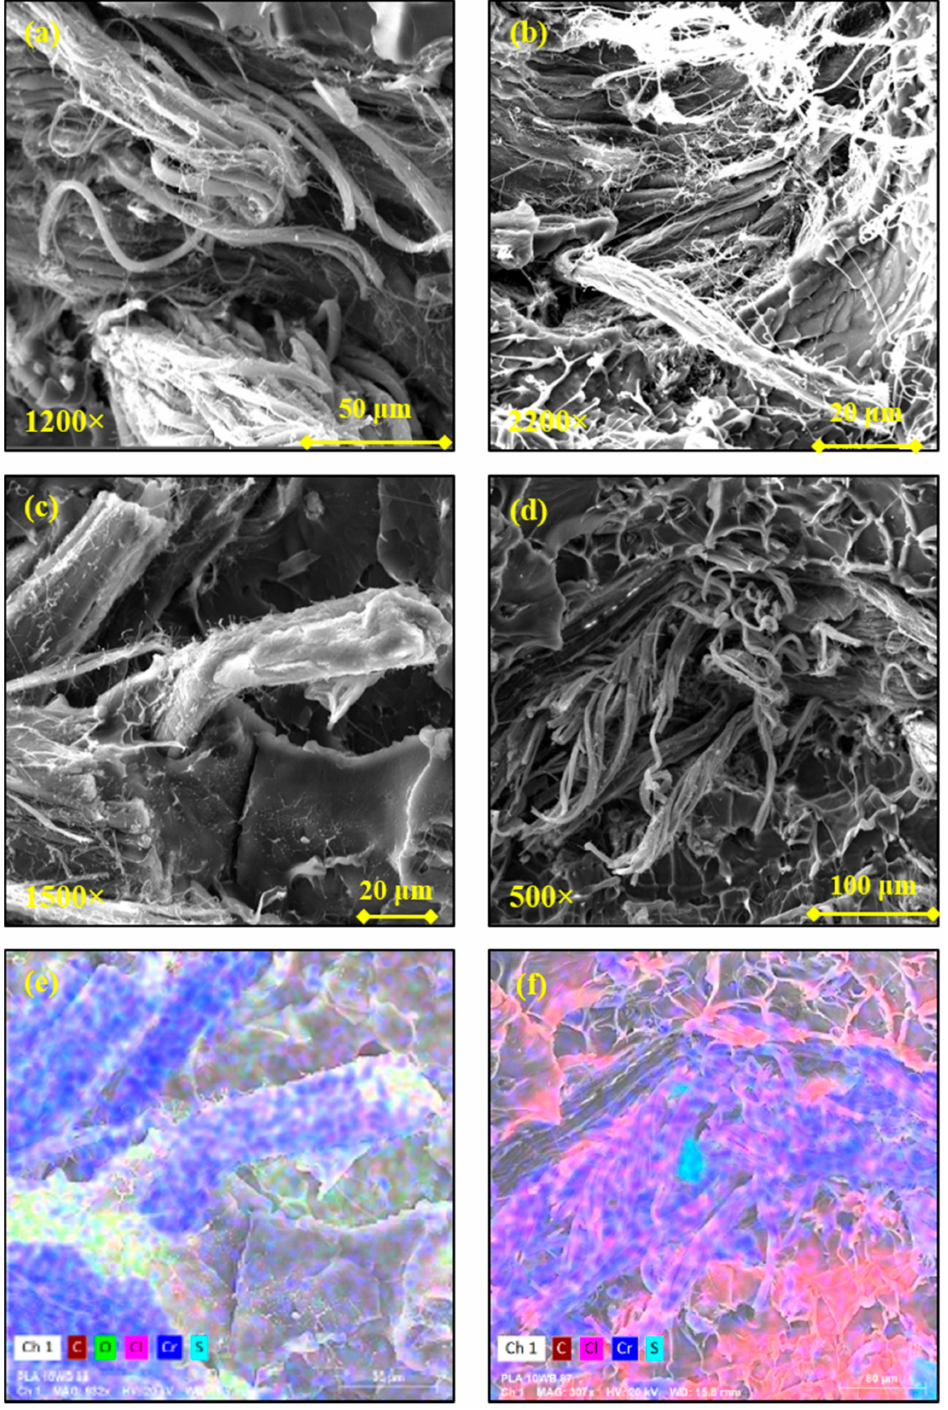
Figure 7. Scanning electron microscope (SEM) images of the PLA10WB sample at different magnifi- cations ( a – d ); ( e ) EDS map of micrograph ( c ) and ( f ) EDS map of micrograph ( d